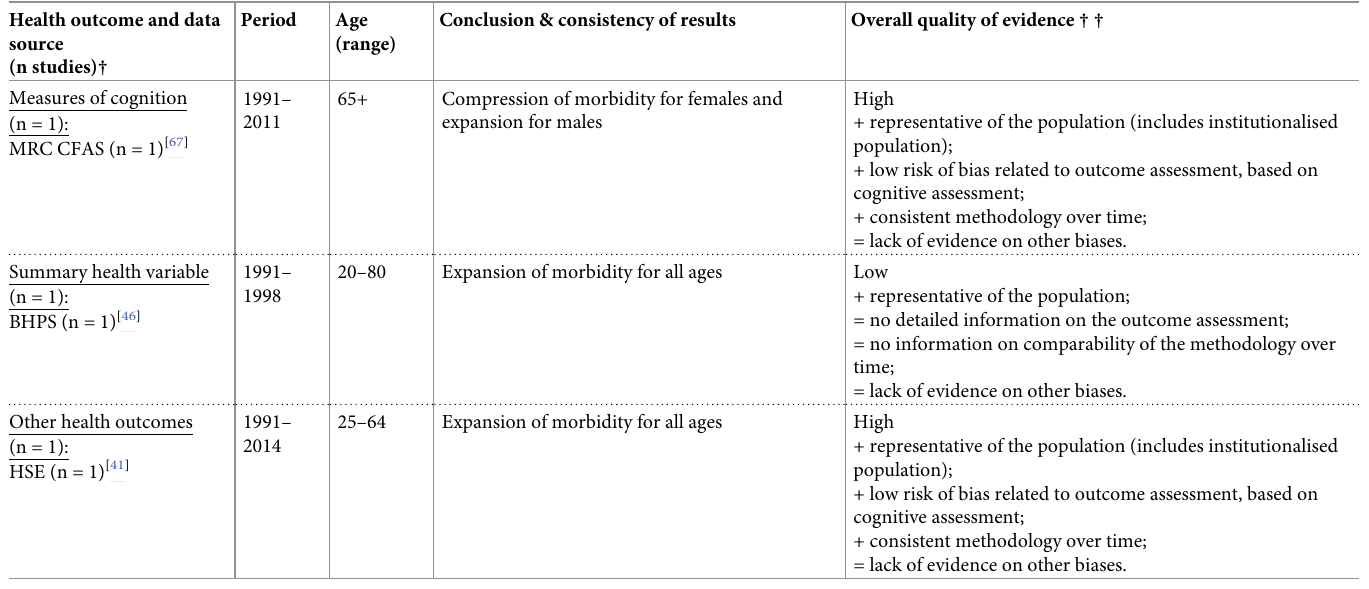
Table 9. The characteristics of evidence on health expectancy, with the emphasis on size, consistency and quality (cont.). Health outcome and data